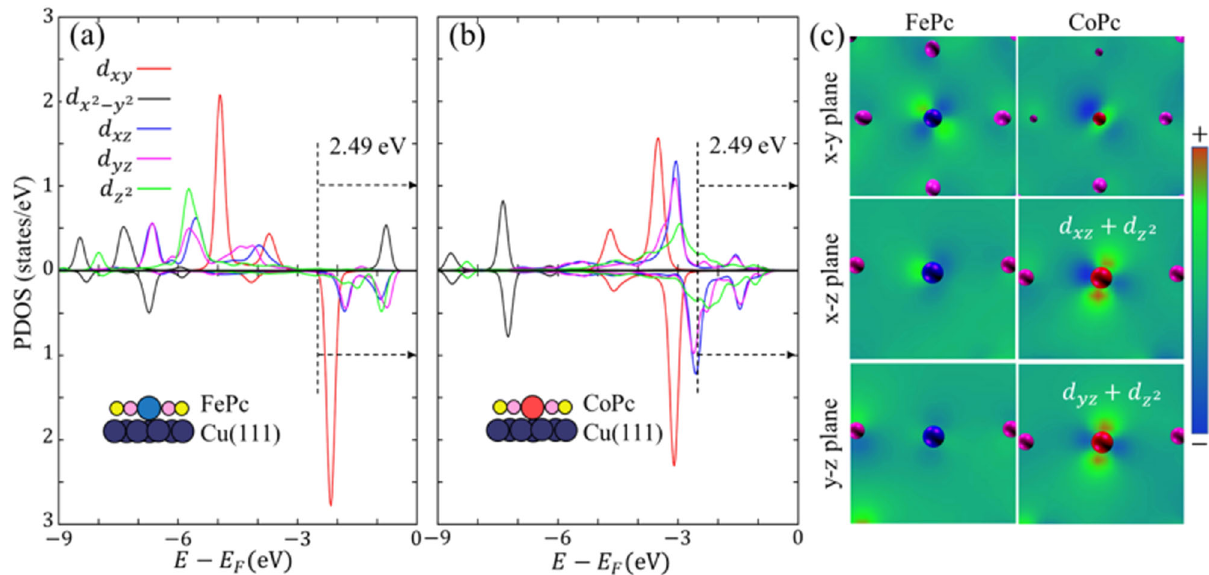
Fig. 4 | PDOS around the metal centers within MPcs. DFT-computed PDOS aroundFe( a )andCo( b )atomswithMPcsonCu(111)surfaces.Thetopandbottom panels correspond to spin-up and spin-down states, respectively. The CO tip is excluded in these results. c 2D volume slice views of the combined states in an energy window of 2.49eV below the Fermi level as indicated by the black dashed